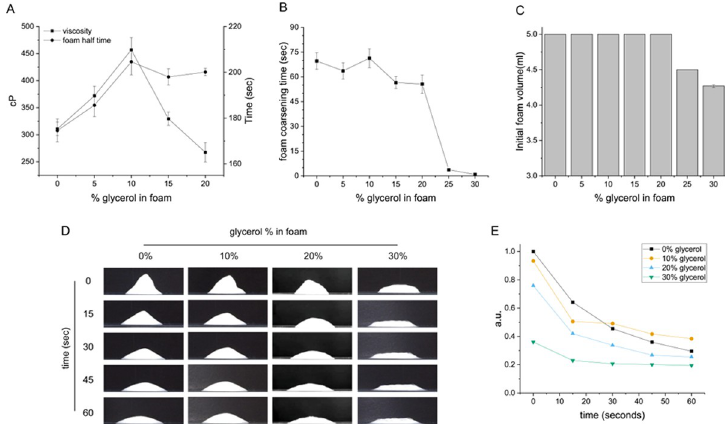
Fig 1. Glycerol enhances the sustainability of the polidocanol foam for cyst sclerotherapy. (A) Foam half time increases as glycerol is added up to 10% (v/v) and then decreases upon additional glycerol addition. The viscosity of the foam also decreased likewise. (B) Foam coarsening time. Foam coarsening time refers to the time when initial foam breakage occurred. (C) Initial foam volume. (D) Representative video capture image of foam. (E) Unregenerated foam height/width data for 60